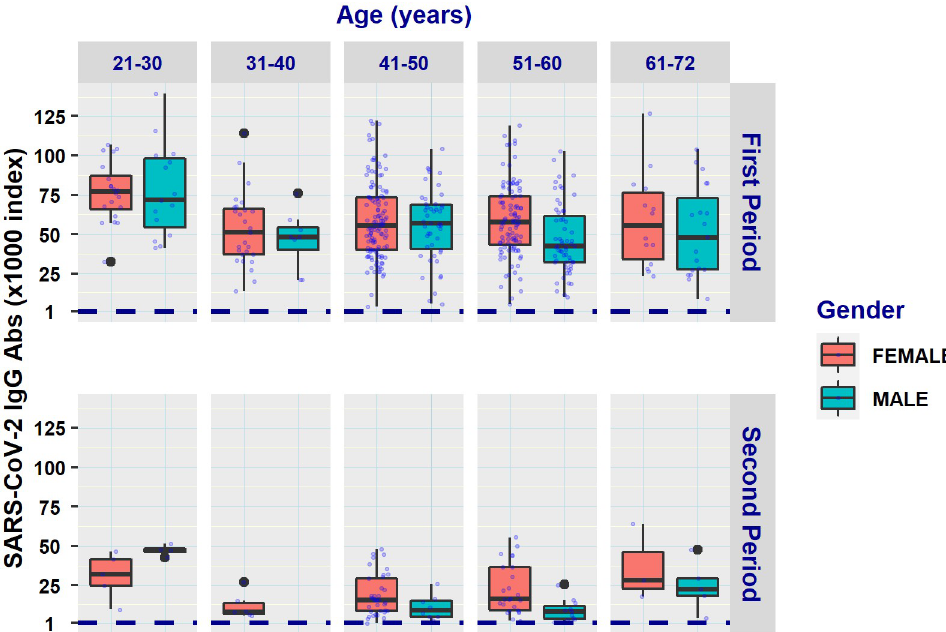
Fig 1. Box plots of SARS-CoV-2 anti-S-RBD antibody titers in females and males classified in different age groups by sampling period (First period: 3–4 weeks after the second vaccine dose; Second period: ~3 months after the second vaccine dose). Jittering was applied to dots for better visualization.